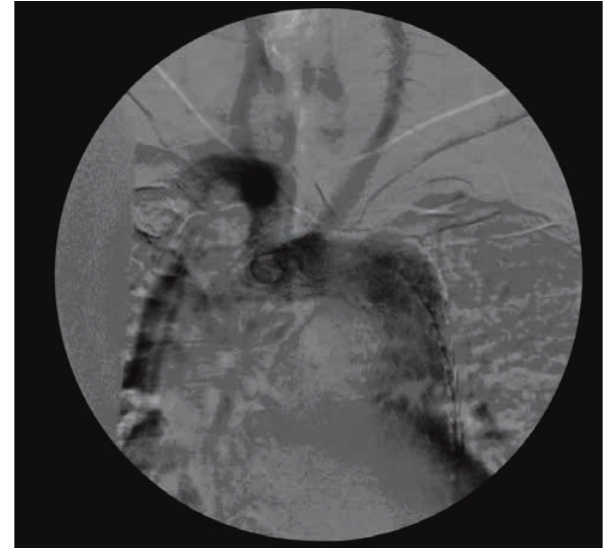
Figure 3: Control angiography following stent-graft implantation into the aortic arch. A complete occlusion of the left subclavian artery ostium.